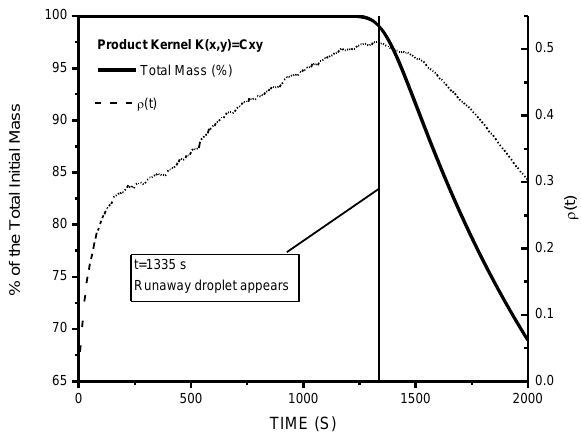
Fig. 2. Time evolution of total mass calculated from the numerical solution of the kinetic collection equation (KCE) for turbulent collision coalescence (solid line and left axis) and the parameter ρ (dashed line and right axis) estimated from the Monte Carlo algorithm.